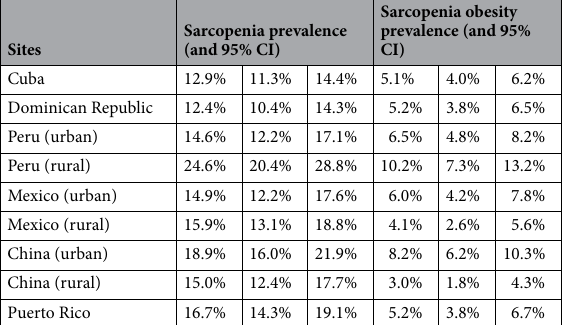
Table 1. Sarcopenia and sarcopenic obesity prevalence per